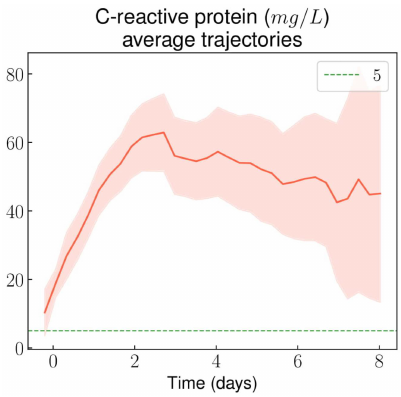
Figure 4. C-reactive protein (CRP) average trajectory throughout non-complicated VOC-related hospital stays.